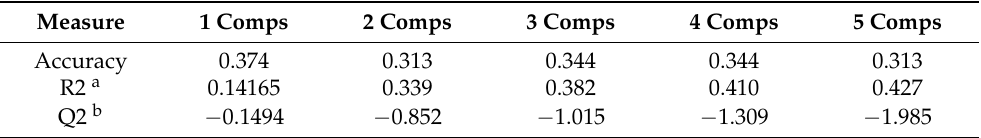
Table 2. PLS-DA cross-validation details for the first 5 components. PLS-DA were performed to cluster groups according to the eCBome quantified at the end of the intervention. Reported Accuracy, R2, and Q2 according to the first 5 components. The analyses were performed using MetaboAnalyst v4.0 (accessed date: 26 November